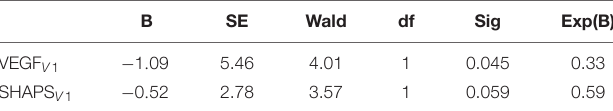
TABLE 4 | Results of binary logistic regression analysis of VEGF level and SHAPS scores at V1 on categories of responder or